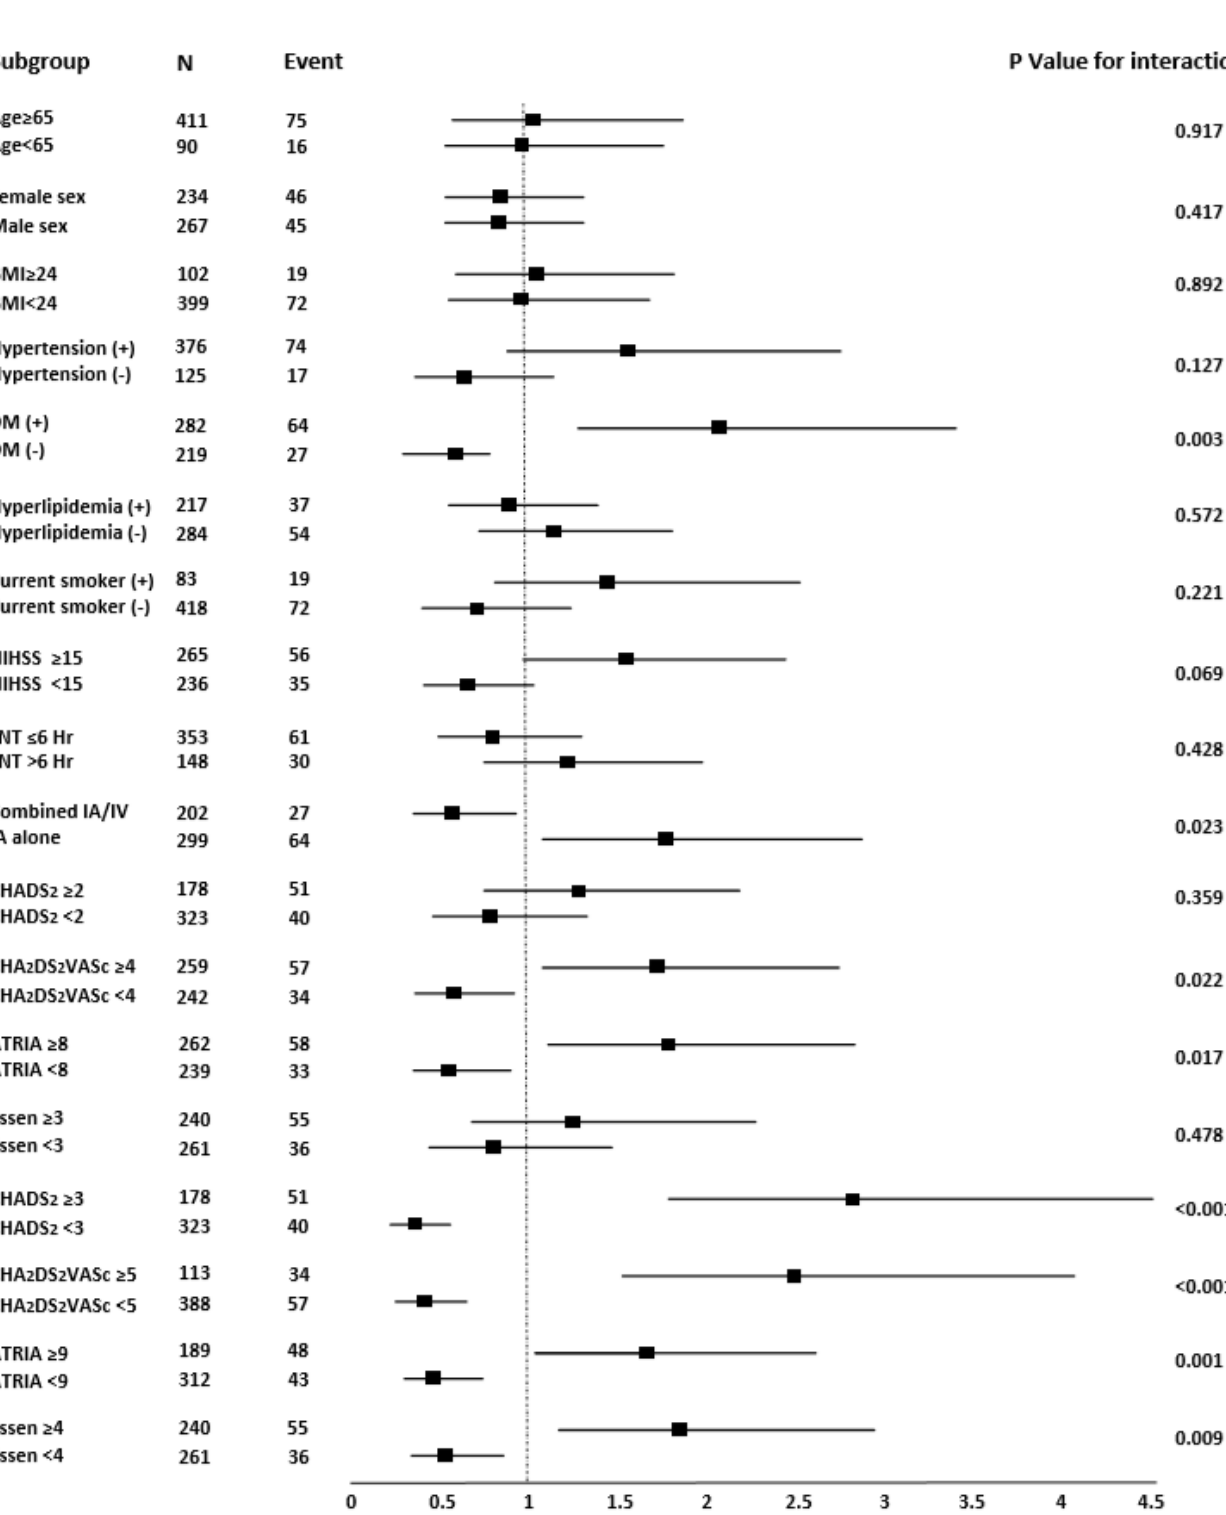
Figure 2. Forest plots of unadjusted odds ratios for unsuccessful recanalization (mTICI ≤ 2a) in patients with endovascular thrombectomy. BMI, body mass index; NIHSS, National Institutes of Health Stroke Scale; LNT, last normal time; IA, intra-arterial; IV, intra-venous; ORs, odds ratios; mTICI, modified thrombolysis in cerebral infarction.